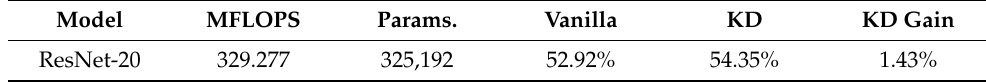
Table 3. Results on TinyImageNet dataset.